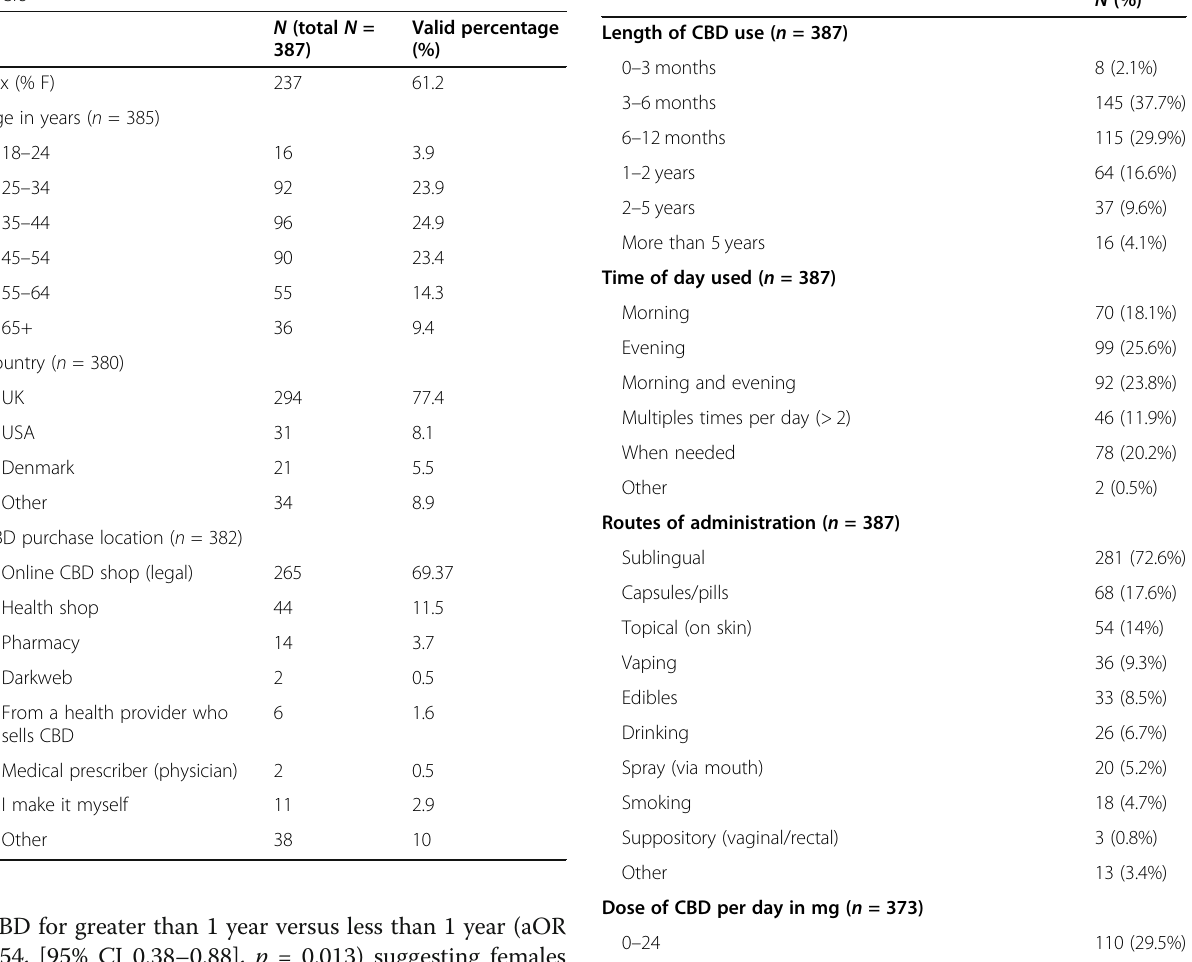
Table 1 Demographic characteristics of 387 adult cannabidiol users